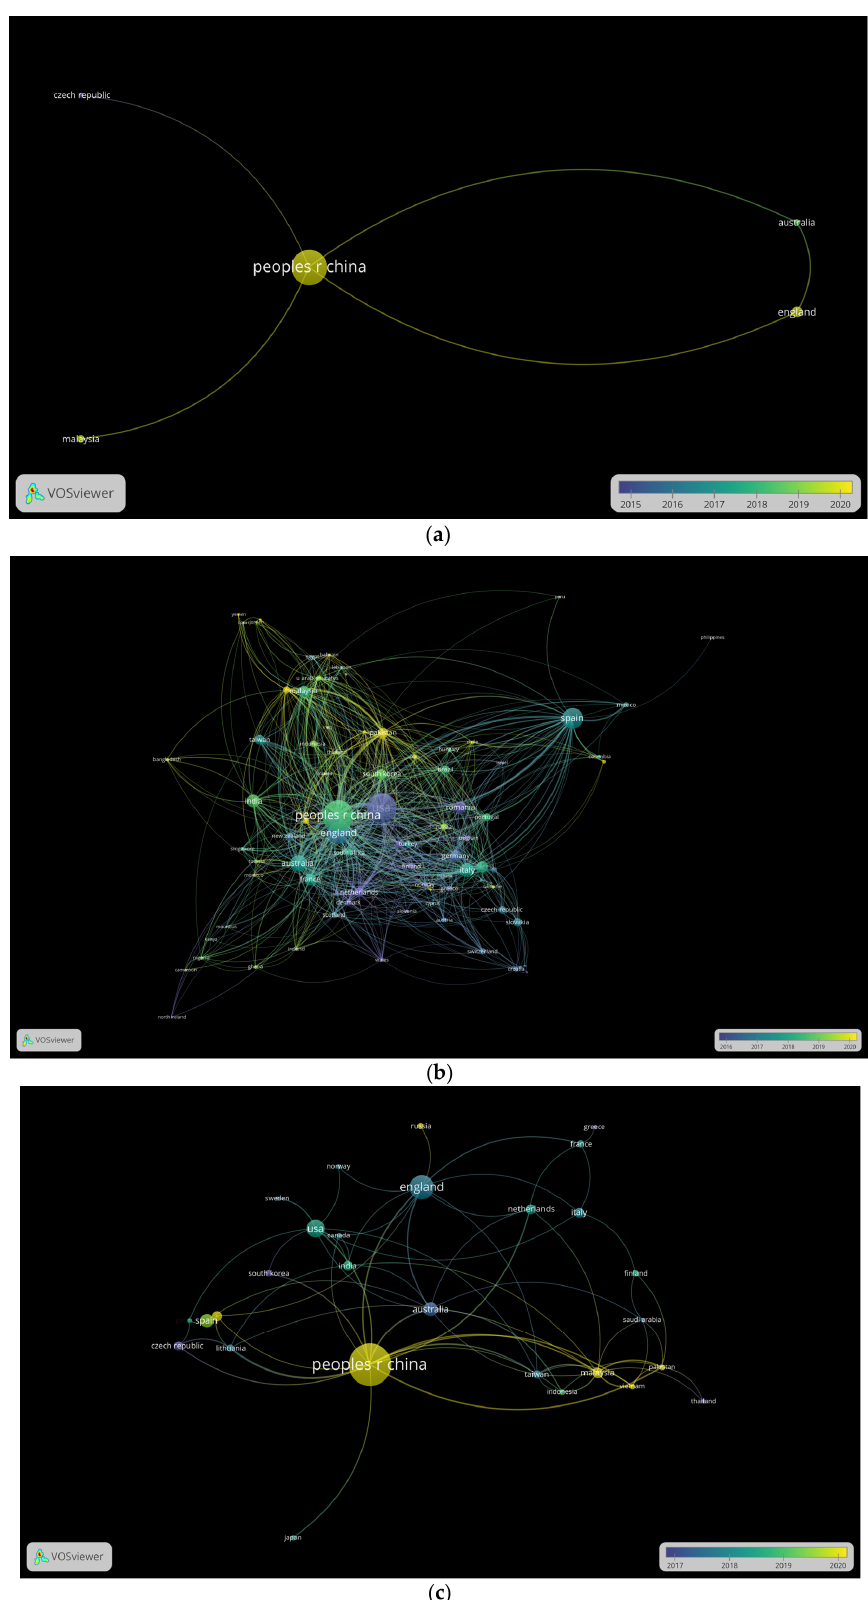
Figure 2. ( a ). Geographical distribution map regarding CSR, environment and energy policy. ( b ). Geographical distribution map regarding CSR and environment. ( c ). Geographical distribution map CSR and energy policy.